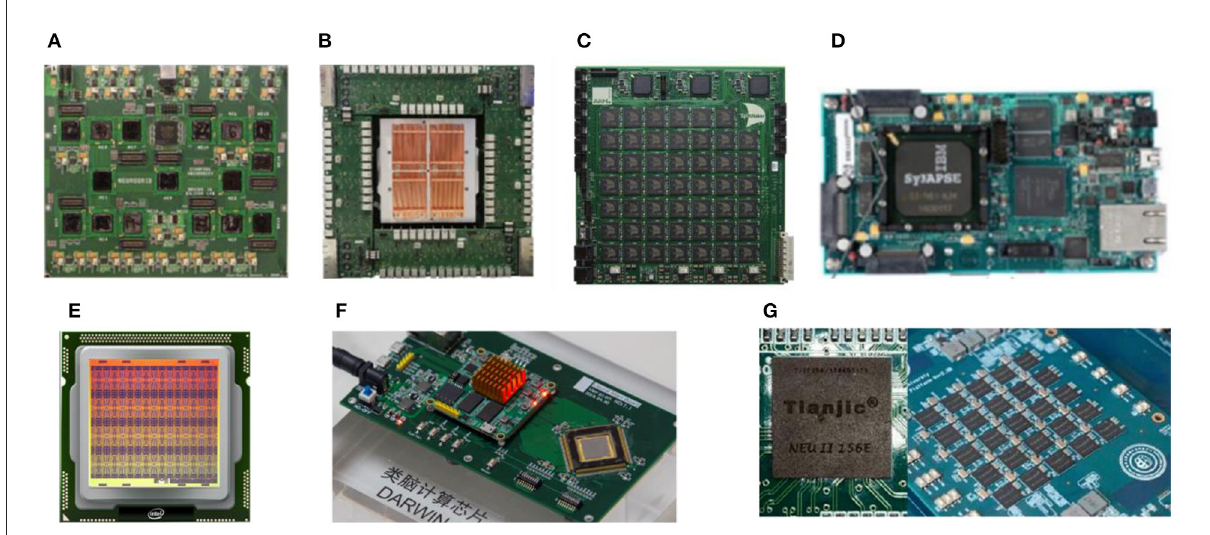
TABLE 1 Prevalent brain-inspired chips.